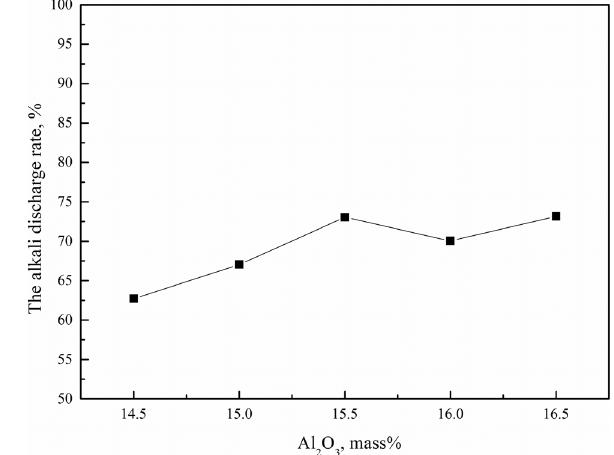
Figure 5: E ff ect of binary basicity on slag alkali metals discharge.